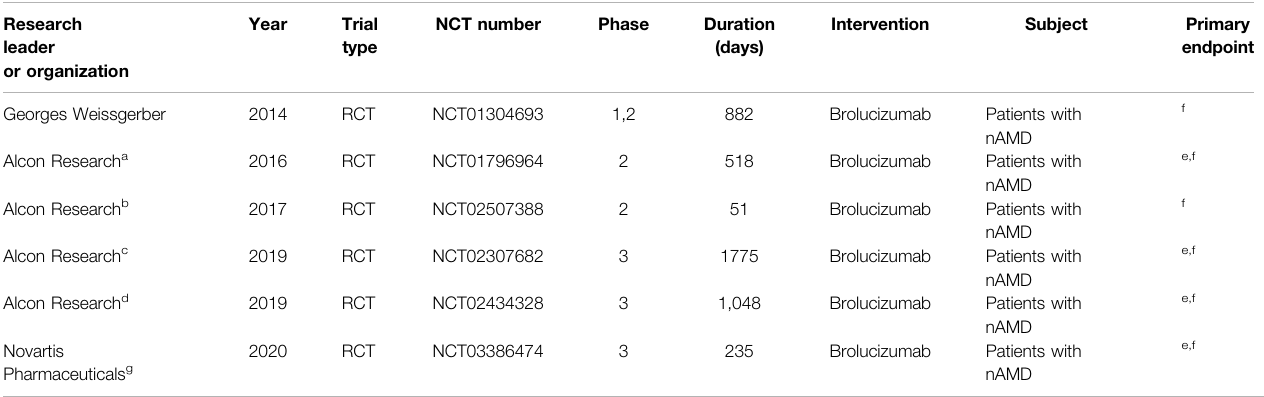
TABLE 1 | Characteristics of the included six RCTs.